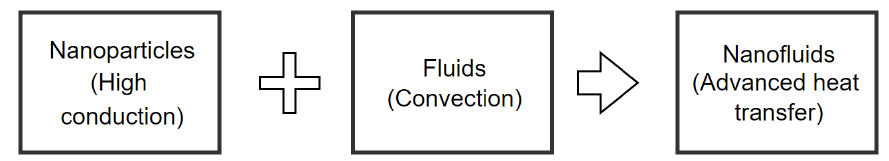
Figure 1. Advanced heat transfer in nanofluids.